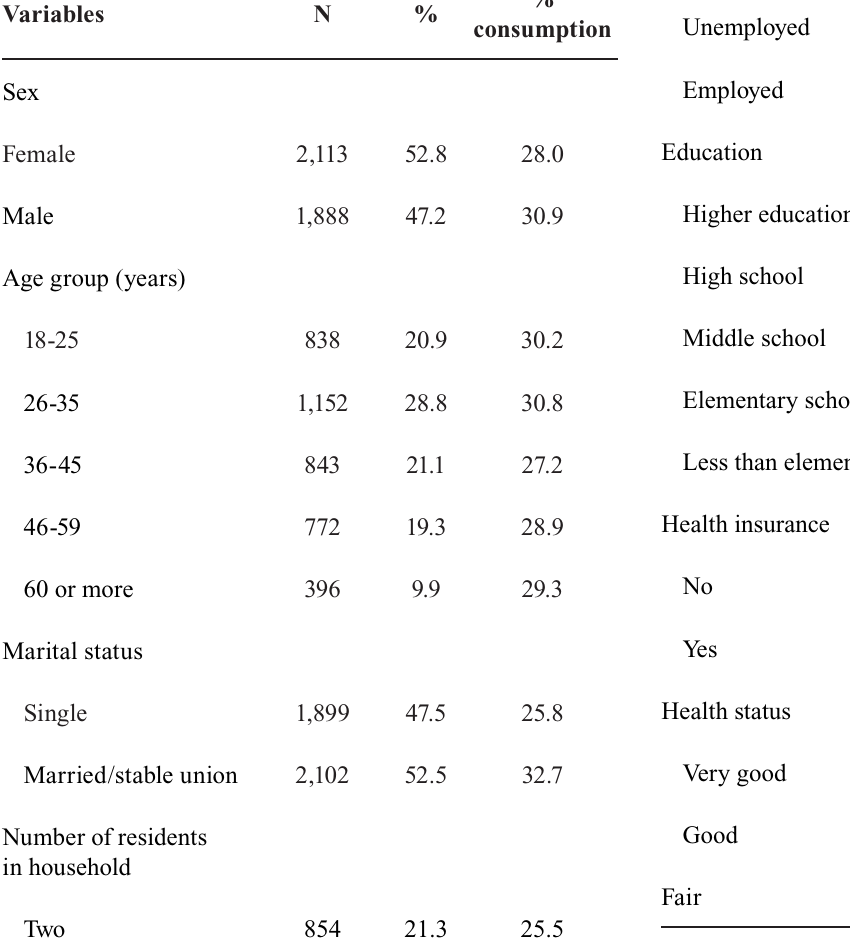
TABLE I - Characteristics of the population and frequency of use of medicines in the 15 days prior to data collection, Manaus Metropolitan Region, 2015 (n=4,001)